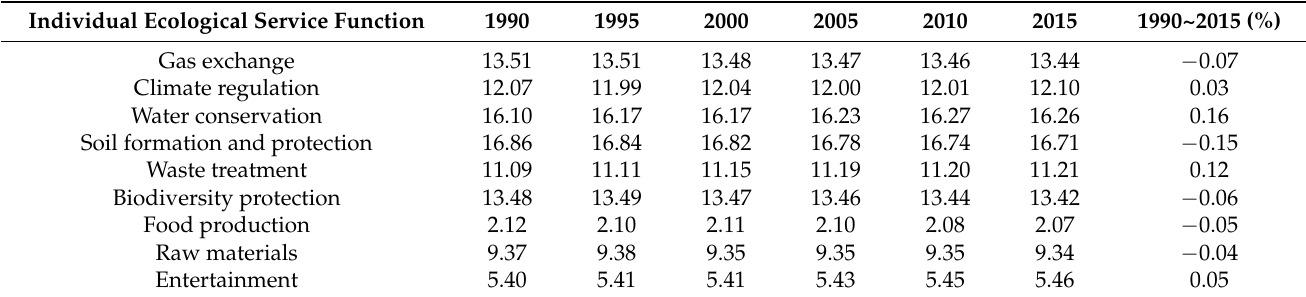
Table 6. Value proportion and change in the individual ecological service